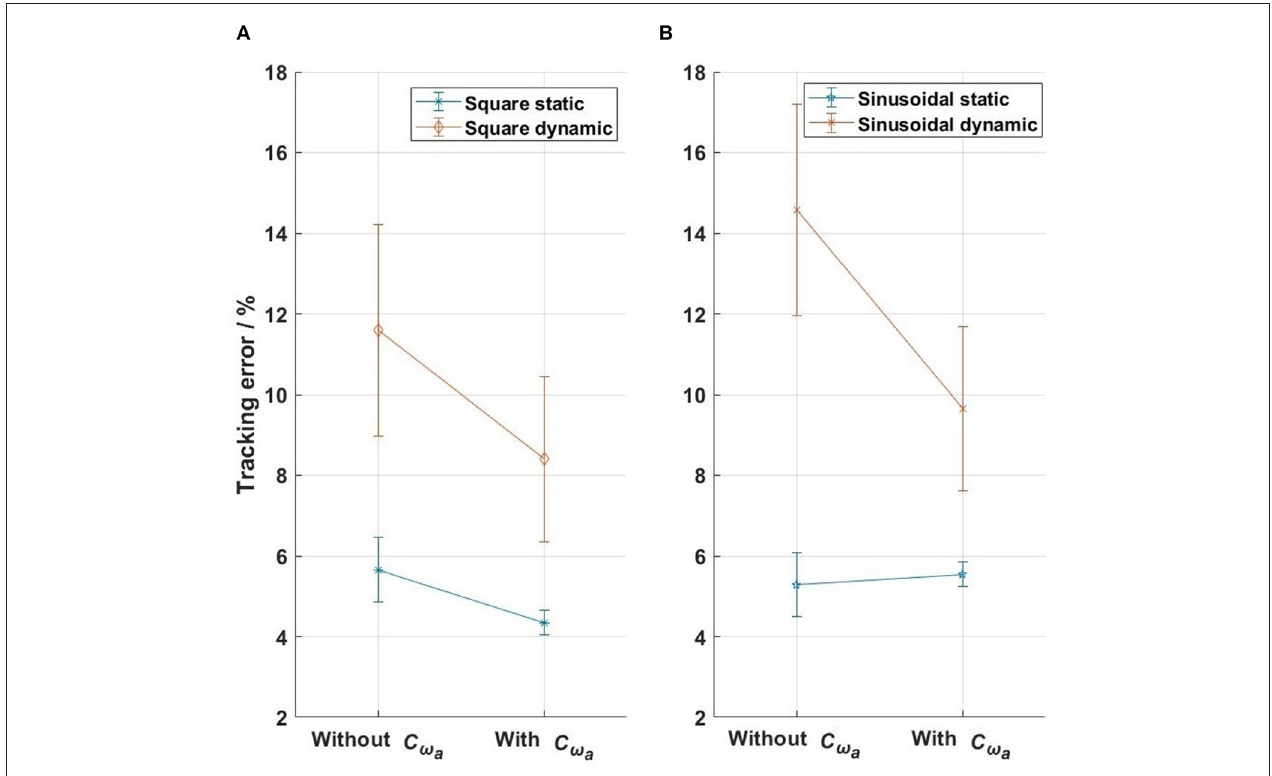
FIGURE 12 | The tracking errors of the four actuators in the evaluation tests. (A) Square-wave reference test, (B) sinusoidal reference test. The bars with points in the middle show the standard deviations and the means of the errors from the four